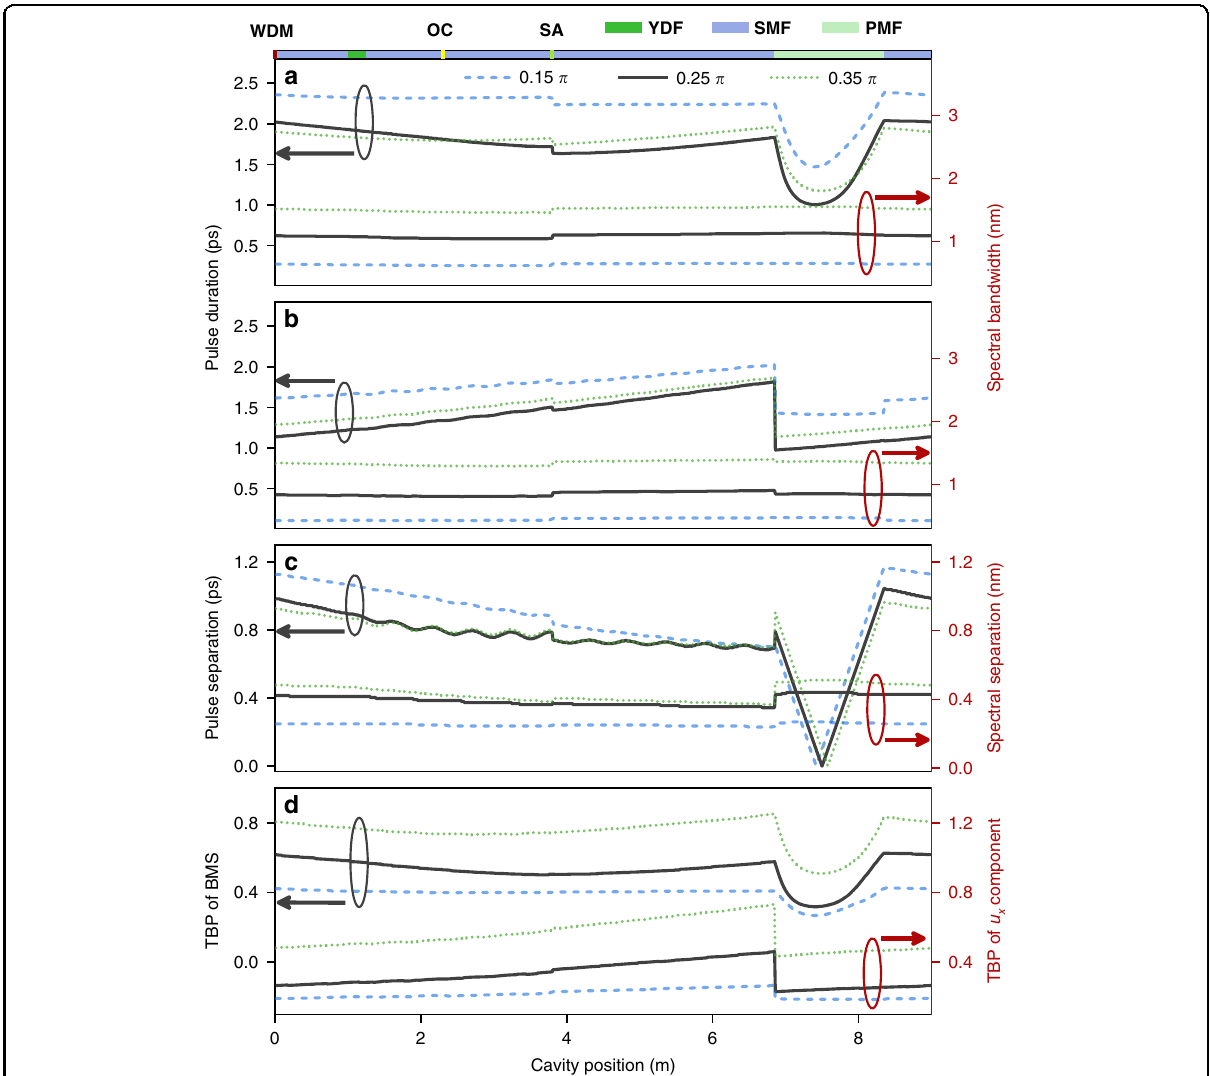
Fig. 7 Intracavity evolution of BMS at θ = 0.15 π (dash blue line), 0.25 π (black solid line) and 0.35 π (dash olive line). Evolution of spectral bandwidth and pulse duration: a BMS and b u x component. c Spectral and temporal separation between u x and u y components. d TBP evolution of BMS and u x